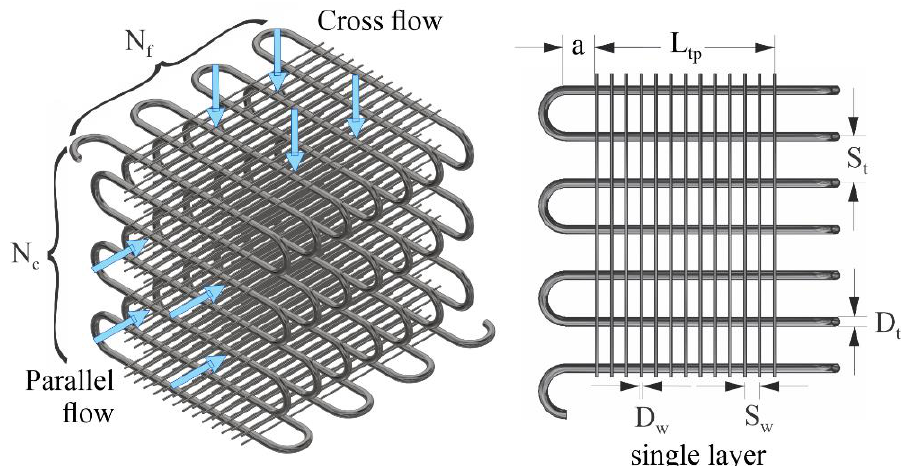
Figure 1. Schematic representation of the multilayer wire-on-tube